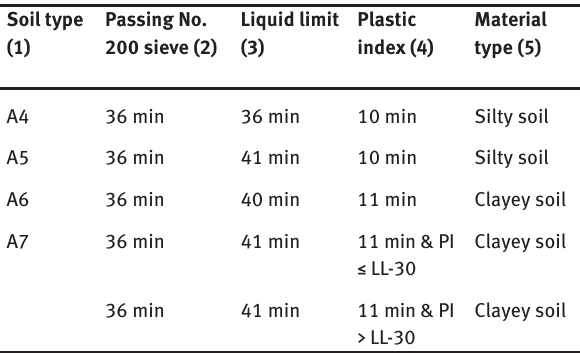
Table 3: AASHTO classification for fine-grained soils (Brajam,